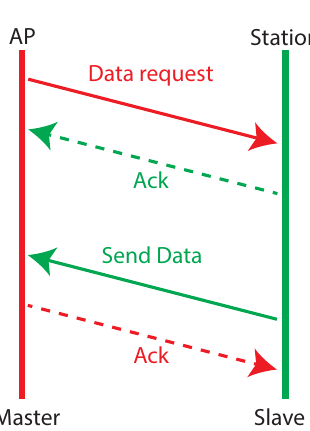
Figure 2. Data transaction between the two Wireless Network Interface Cards (WNICs). Table 1. Settings of the experimental testbed.